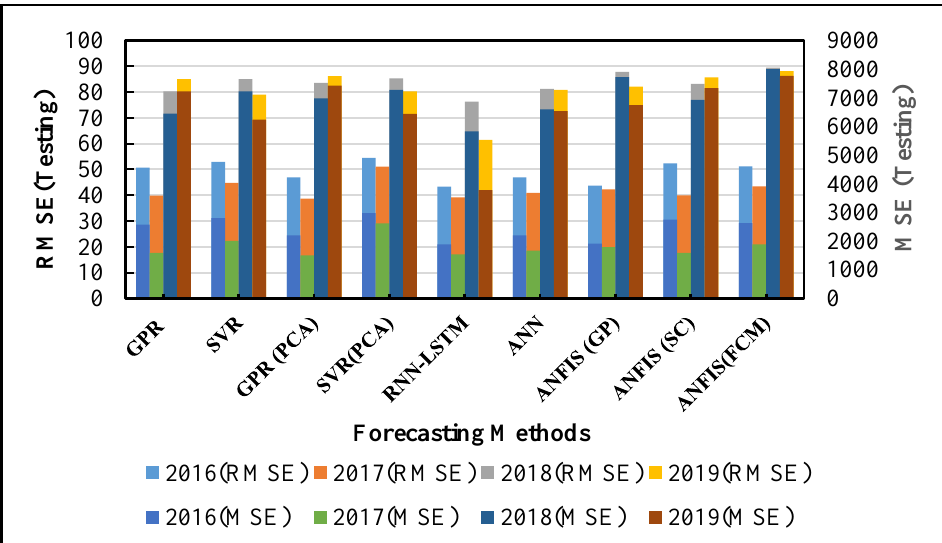
Figure 8. Comparison of RNN-LTSM test results of RMSE and MSE for m-si with other techniques over the period of four years (2016–2019).